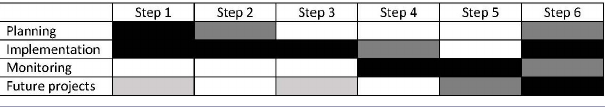
Fig. 2 . Potential of evaluation to cause changes in project planning, implementation, monitoring, and future projects. Black = high potential; Dark gray = moderate potential (modifies some but not all projects); Light gray = possible changes on rare occasions but lack of documentation (at least in the projects analyzed in the present study); White = changes are unlikely to happen. Evaluation steps are defined in the Introduction and in Table